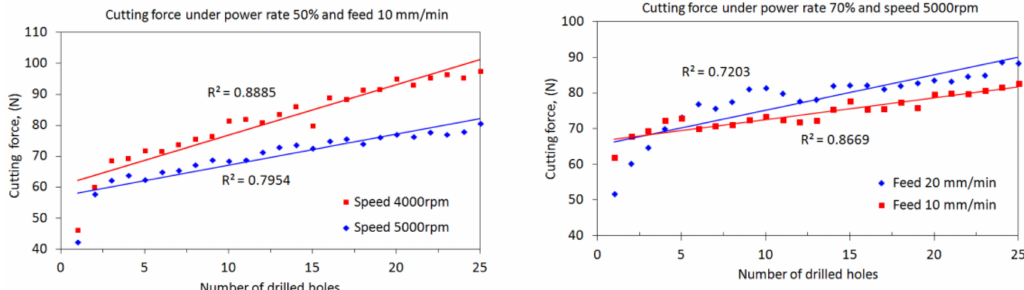
Figure 8. Effects of spindle speed and feed rate on the cutting